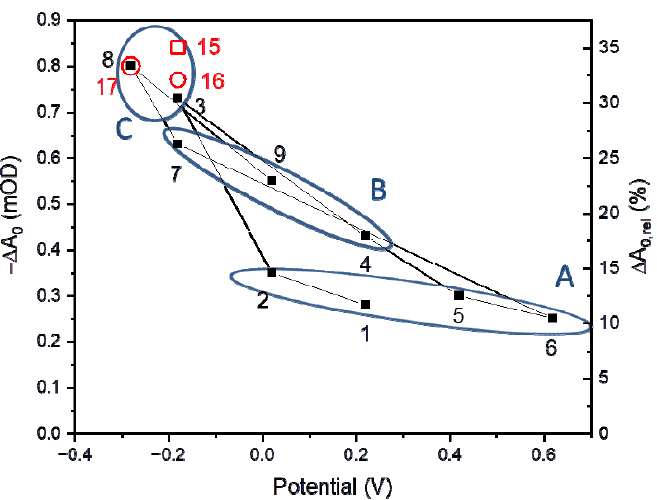
Figure 7. Initial photobleaching amplitudes as a function of voltage applied to PSI-FTO electrode. Data points obtained in the absence of redox compounds in the electrolyte are represented by filled squares (first nine numbered data points from Table 1). Data collected in the presence of 10 mM ascorbate and 200 µ M DCPIP are represented by red symbols (data points 15–17 from Table 1). Squares refer to excitation frequency 0.05 Hz, and circles—0.5 Hz. Labels A, B, and C refer to the three distinct groups of kinetics shown in Figure 6b. Left axis—absolute amplitudes, right axis—relative